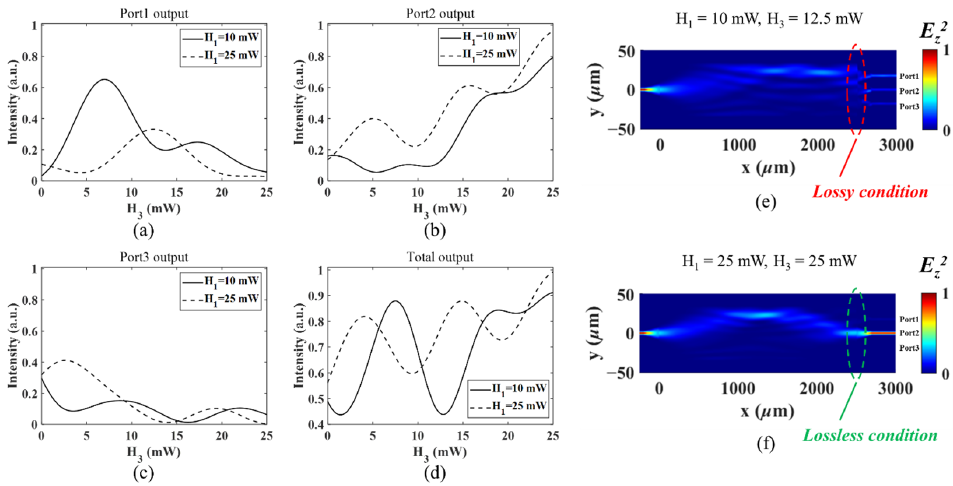
Figure 4. The simulated optical intensity variation of ( a – c ) Port1–Port3 and ( d ) their total outputs when H 3 varies from 0 to 25 mW under different H 1 values. The simulated results under different thermal configurations: ( e ) H 1 = 10 mW, H 3 = 12.5 mW (lossy condition); ( f ) H 1 = 25 mW, H 3 = 25 mW (lossless condition). All the intensity values are normalized by the total output intensity of the initial 3 dB splitter (Port1 and Port3) without any heater power applied.